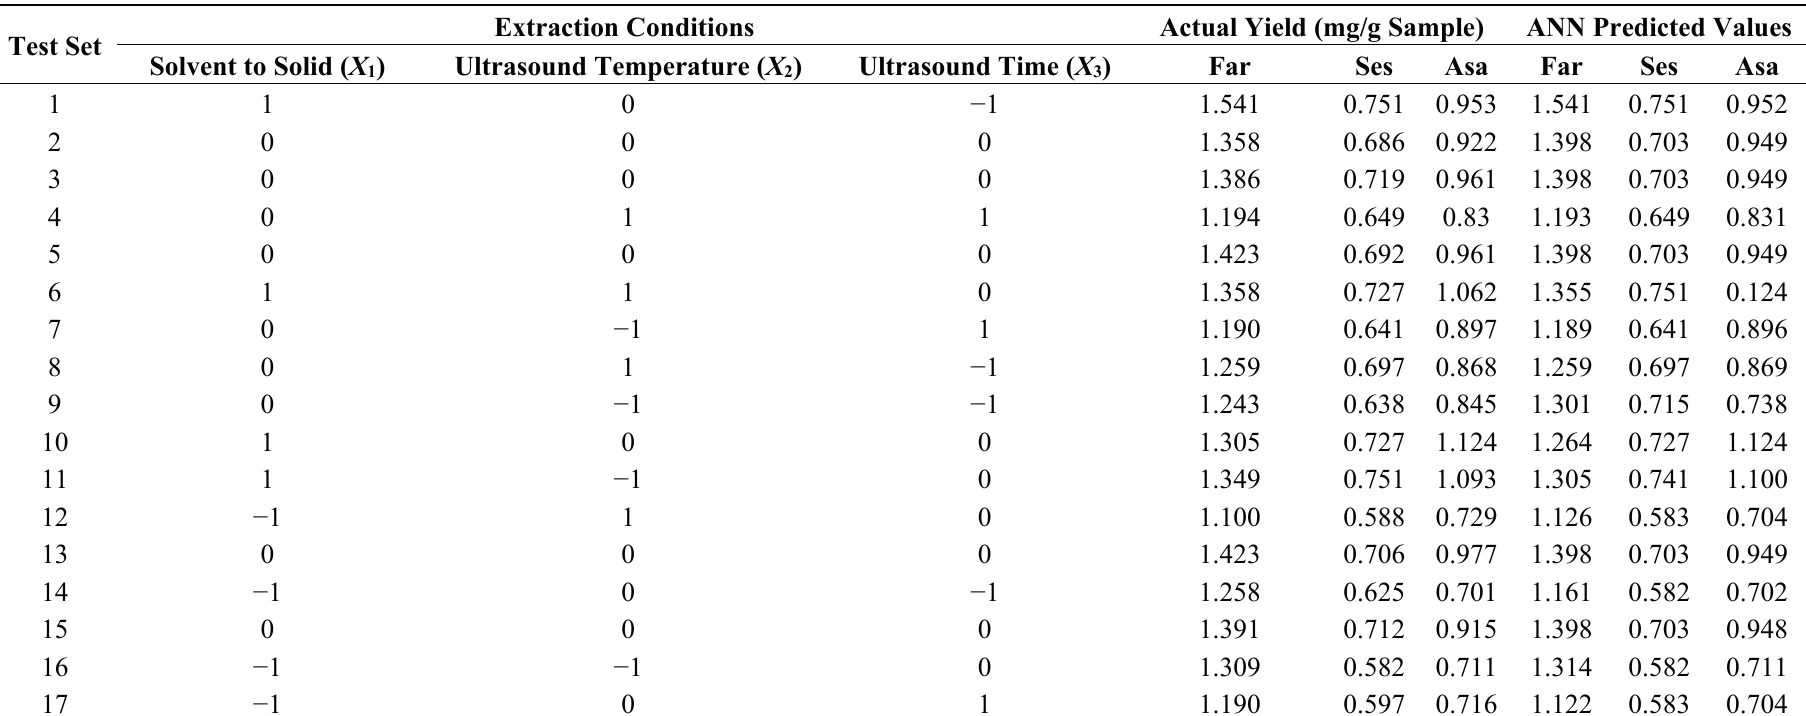
Table 1. Experimental design of the BBD of the true yield of lignans and the ANN predicted